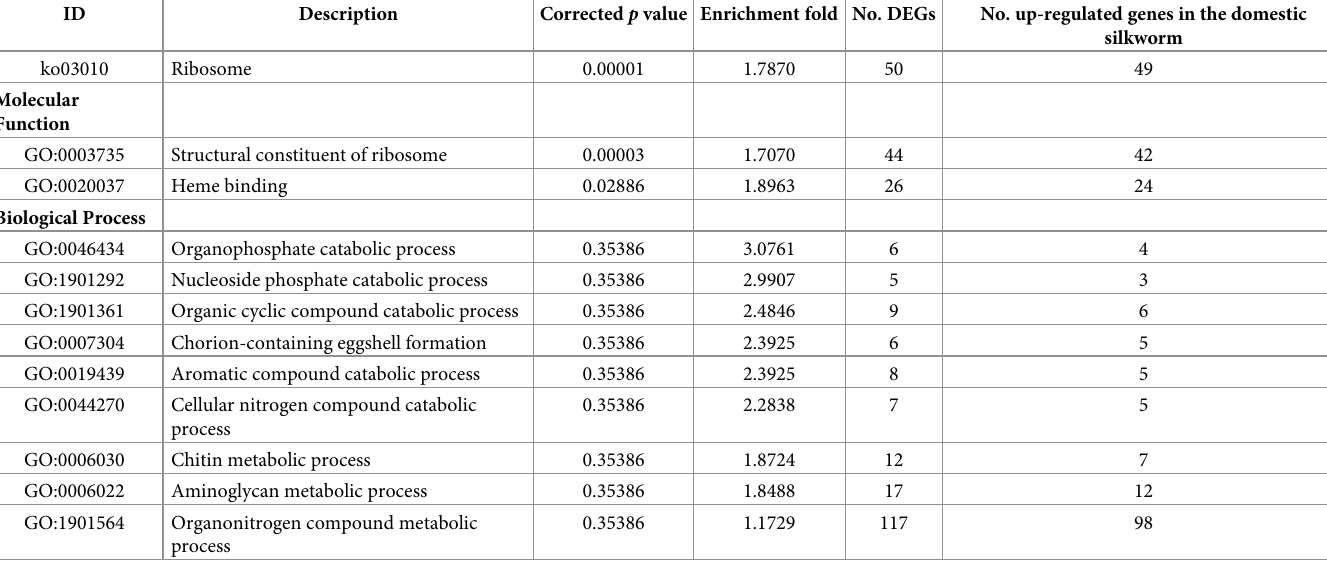
Table 4. Functional enrichment of differential expressed genes between the wild and domestic